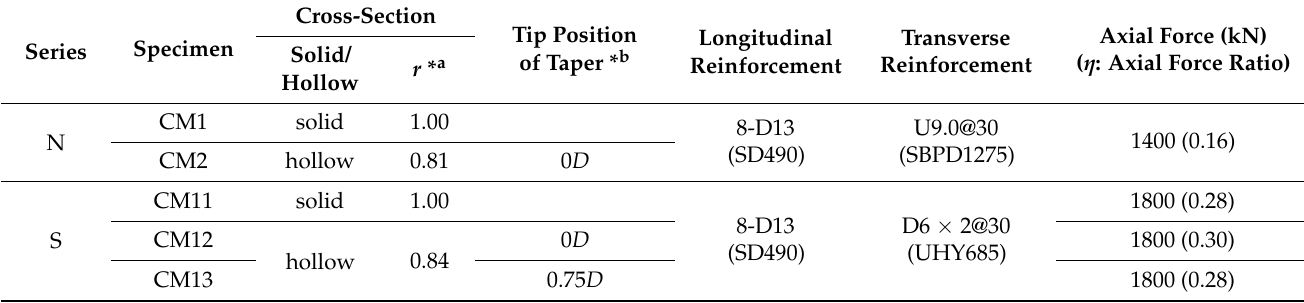
Table 1. Specimen properties.